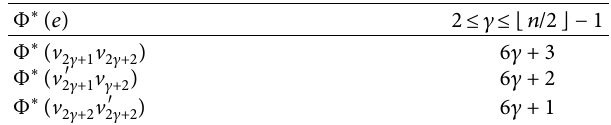
Table 35: Edge labeling of Φ ∗ ( e ) .